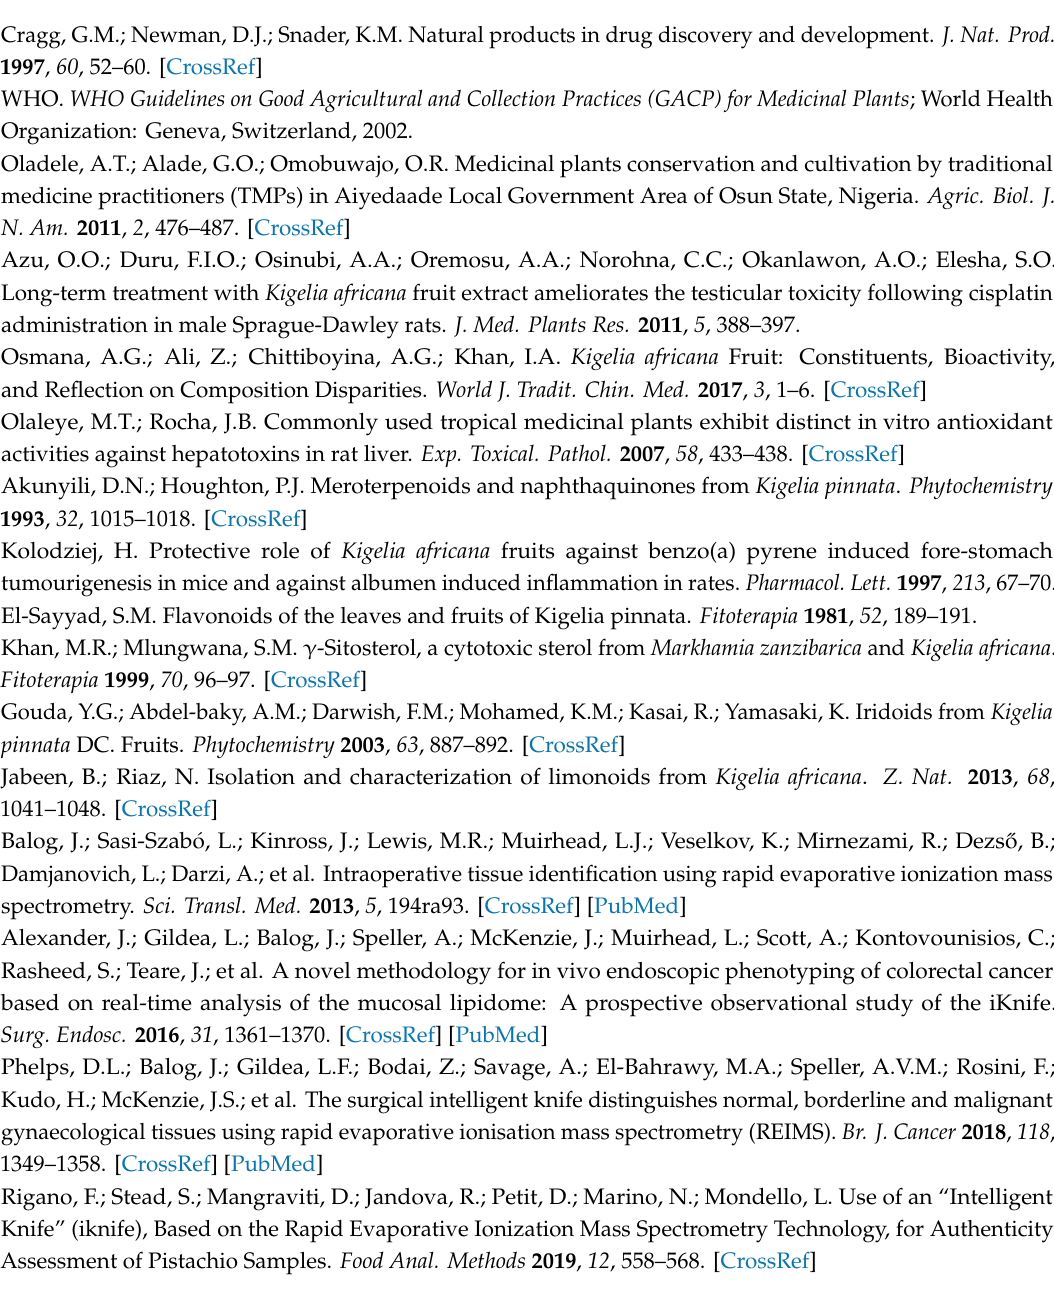
to the loss of water, while the ion at m / z 225.04 is the loss of the carbonyl group after the opening of the pyranone ring. Figure S8 : MS / MS spectrum over the range 100–500 of m / z 487.08 obtained in positive ionization mode at a collision energy of 30 eV, by cutting the sample at FC 20 W. Figure S9 : MS / MS spectrum over the range 50–1200 of m / z 523.14 obtained in negative ionization mode at a collision energy of 30 eV, by cutting the sample at DC 10